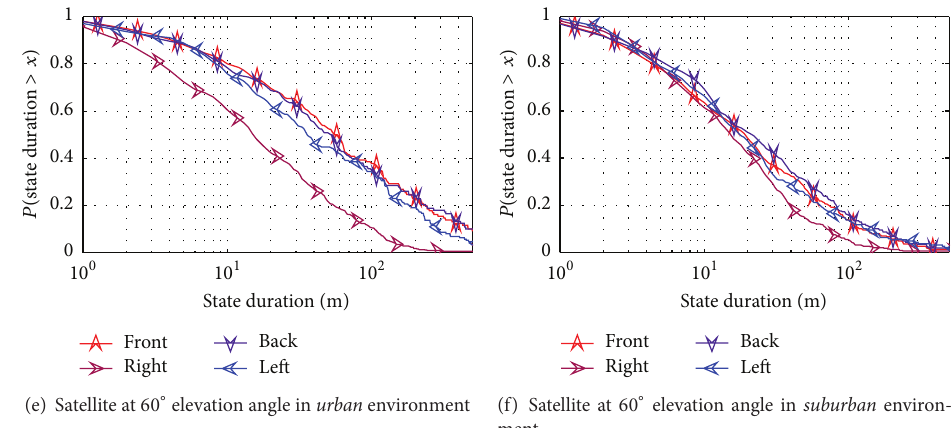
Figure 15: State duration statistics for the good state with respect to different driving directions and elevation angles in urban (left) and suburban environment